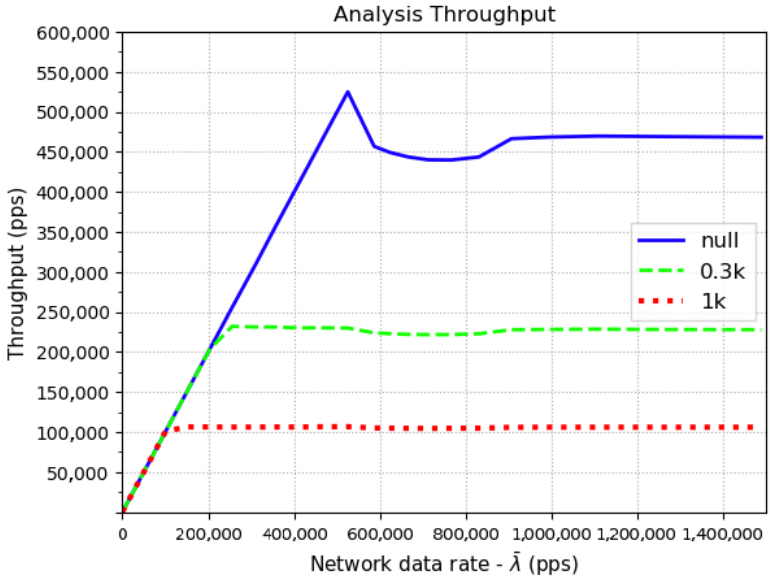
Figure 8. Simulated performance of the optimal